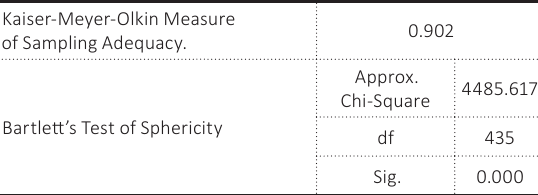
Table 3. KMO and Bartlett’s test